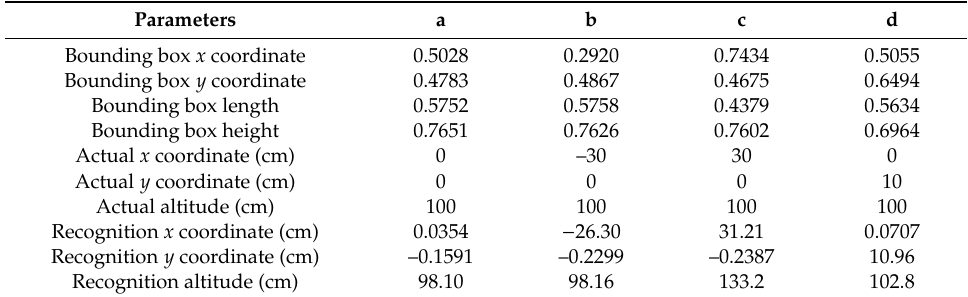
Figure 18. YOLO real-time recognition location UAV. ( a – d ) Four sets of localization experiments. As seen in Table 3, when the UAV is away from the image boundary, it can be located accurately, but when the UAV approaches the image boundary or goes beyond the image range, the accuracy of the location may decrease. Table 3. You Only Look Once (YOLO) real-time recognition location results.